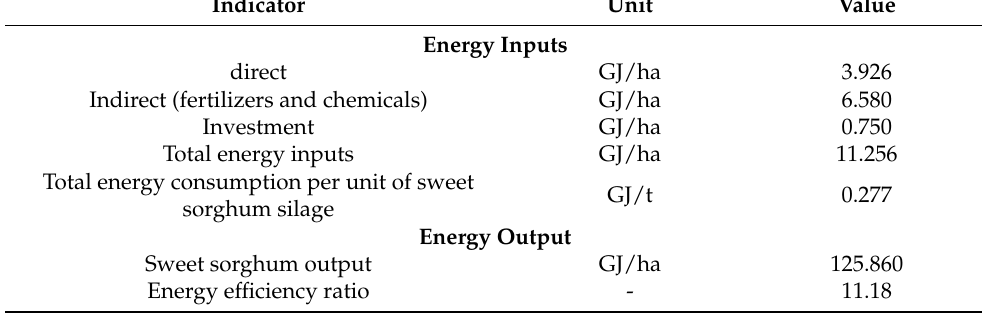
Table 9. The main energy indicators of the technology.